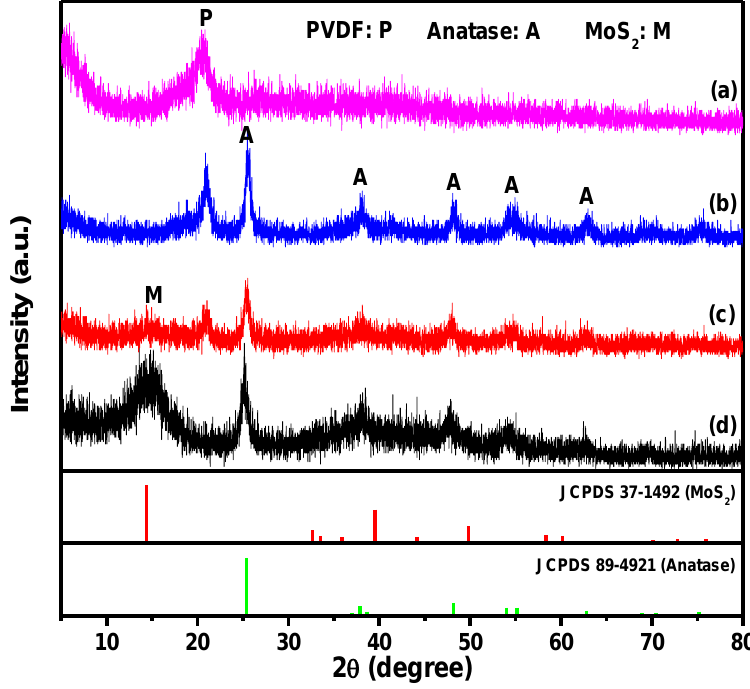
Figure 2. XRD patterns of ( a ) TBOT/PVDF fibers, ( b ) TiO 2 /PVDF hybrid fibers, ( c ) TiO 2 /PVDF@MoS 2 core-shell heterostructured fibers, and ( d ) MoS 2 and TiO 2 powders.